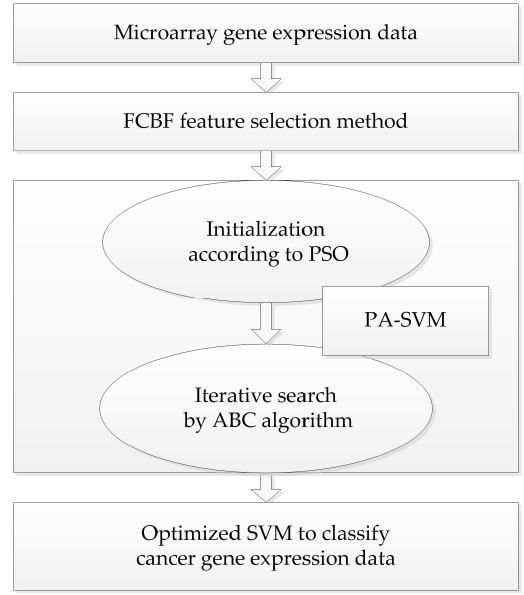
Figure 4. The whole frame of the proposed PA-SVM algorithm.